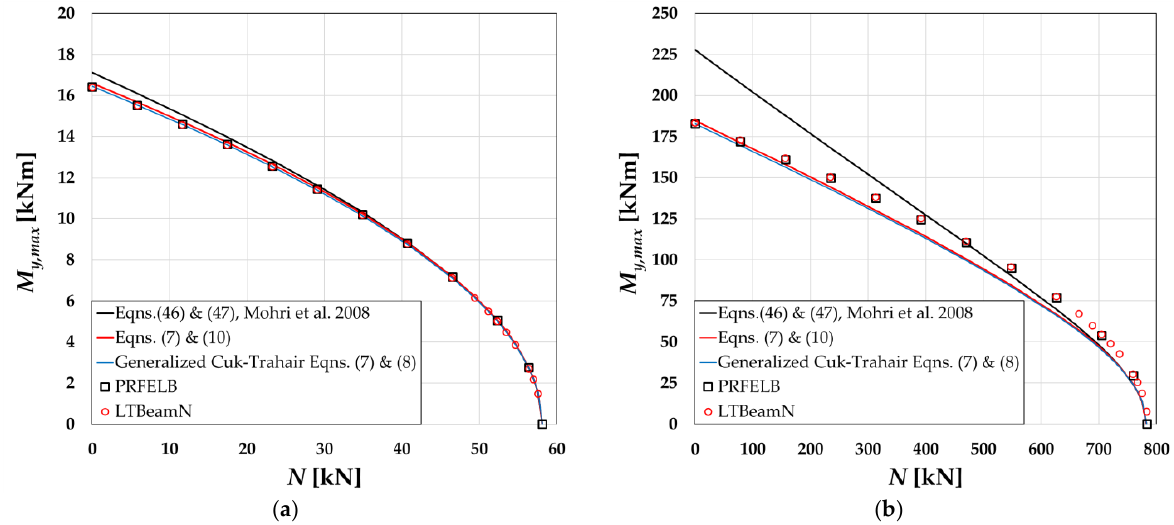
Figure 4. Verification of results from the present study with those of Mohri et al. [20] and computer programs LTBeamN and PRFELB for Case 1 of the in-plane loading system: ( a ) beam-column of are compared with those of the finite-element software (circles from LTBeamN [21] and section IPE 180; ( b ) beam-column of section HEB 180. squares from PRFELB [12]).